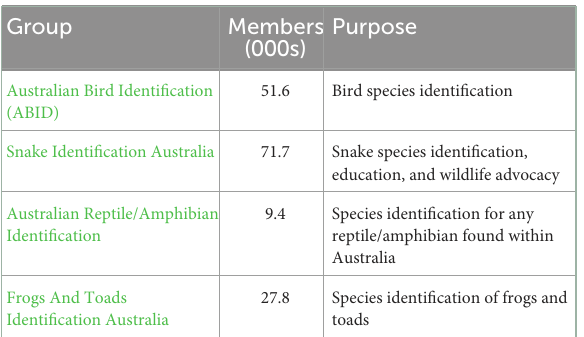
TABLE 1 Examples of Facebook Groups from Australia dedicated to the identification of vertebrates, including the number of members (as of October 2022), and their stated